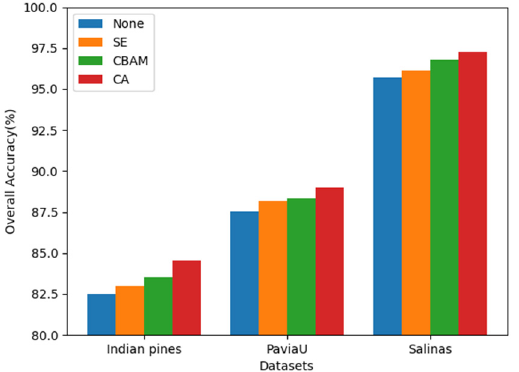
Figure 18. The influence of the different attention modules.